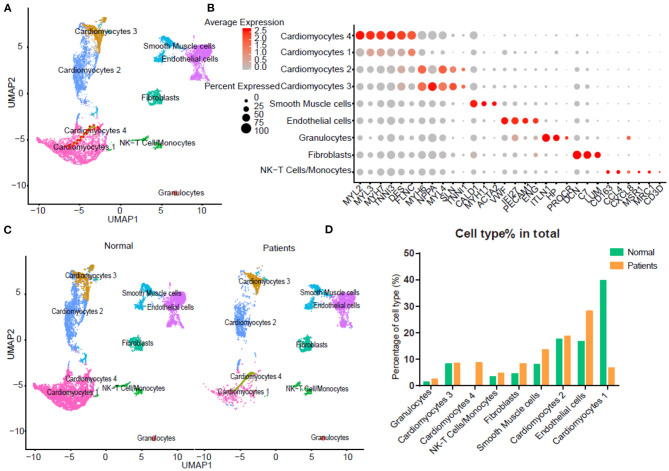
Integrated analysis of normal and heart failure (HF) conditions at single-cell resolution. (A) Uniform manifold approximation and projection (UAMP) clustering of 14,698 cells isolated from normal and heart failure patients. Each dot represents a single cell. Cell type was annotated by the expression of known marker genes. (B) Dot plotting showing gene signature among different clusters, the shadings denotes average expression levels and the sizes of dots denote fractional expression. (C) Split views show the 9 subsets in normal and patient group. (D) The percentage of cell number for different cell types in normal and patient group.